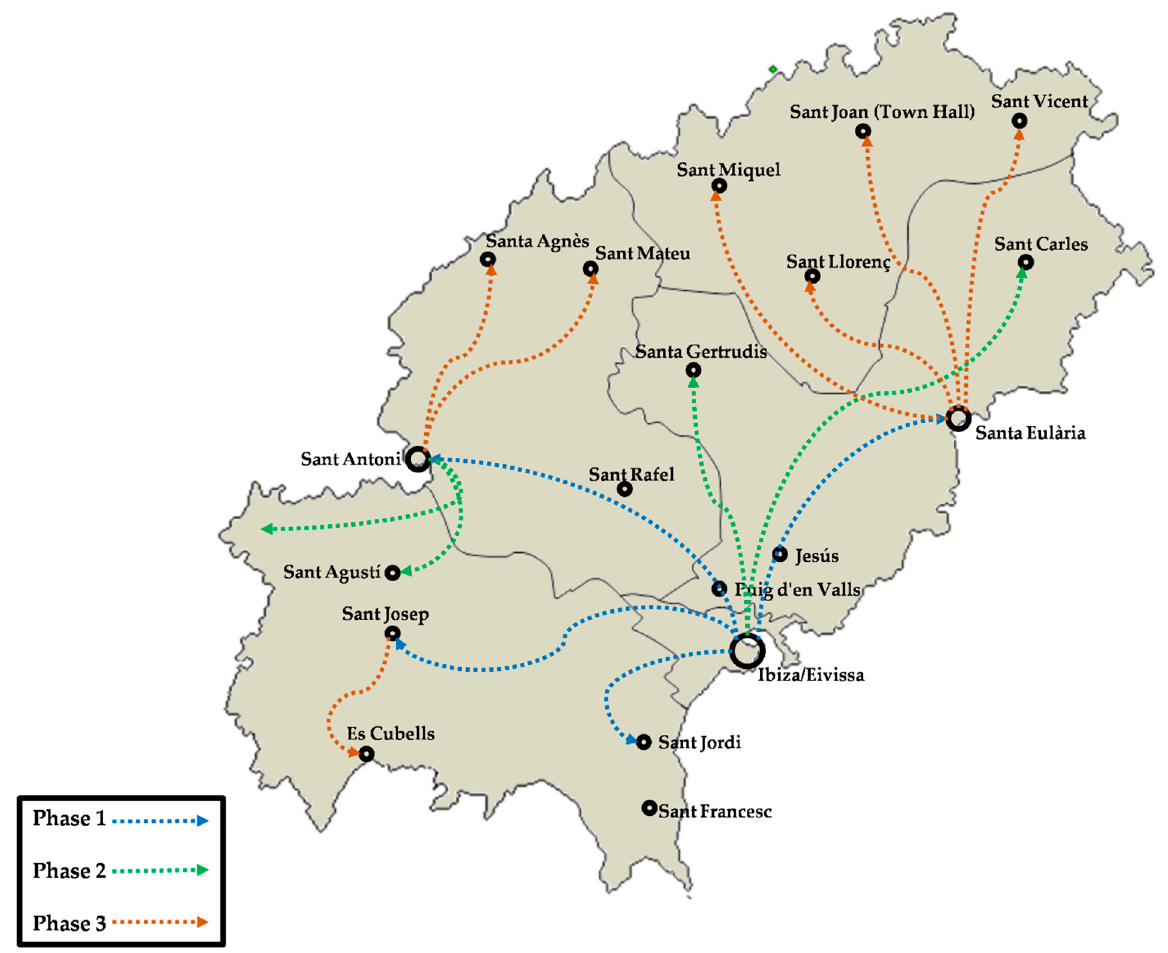
Figure 3. Expansion of the countercultural presence (authors’ own elaboration).